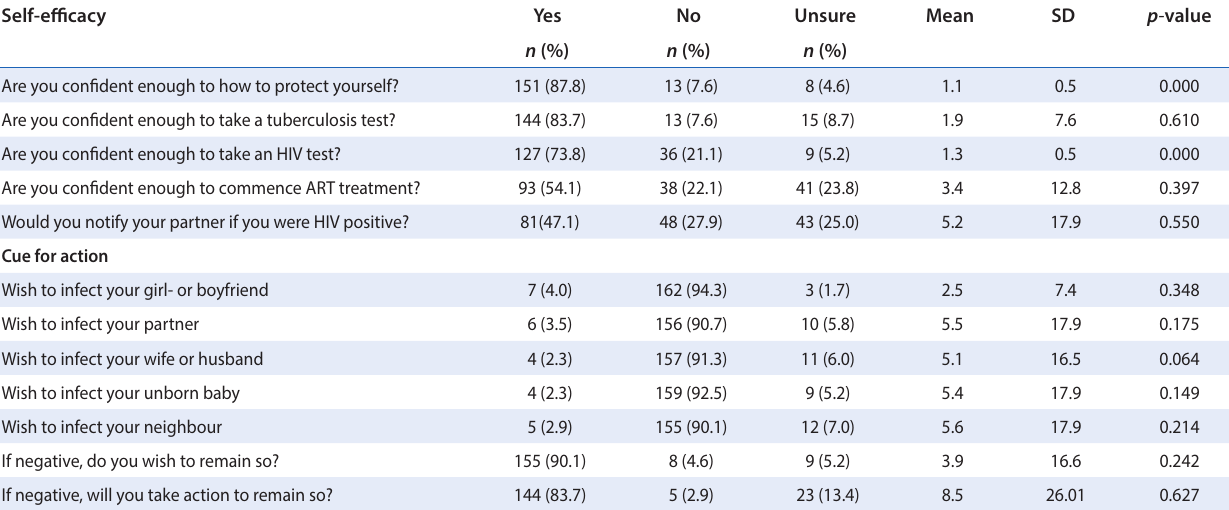
Note: ART: antiretroviral therapy, HIV: human immunodeficiency virus, SD: standard deviation.